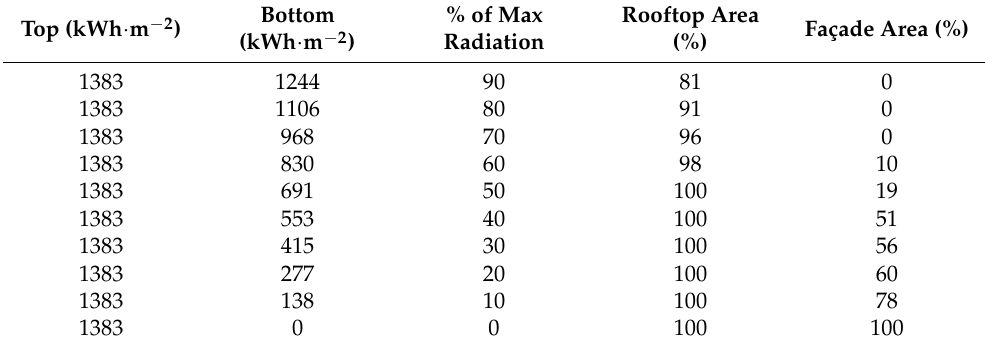
Table 5. Radiation analysis on the existing buildings (scenario 0; Figure 4). Top and bottom represent ranges of annual radiation received on meshes. “% of max radiation” indicates percentage of the maximum annual radiation (1383 kWh · m − 2 ). Rooftop and façade areas are percentages of the total areas. For example, 81% of the rooftop area received more than 90% of the maximum annual radiation. Top (kWh · m − 2 )